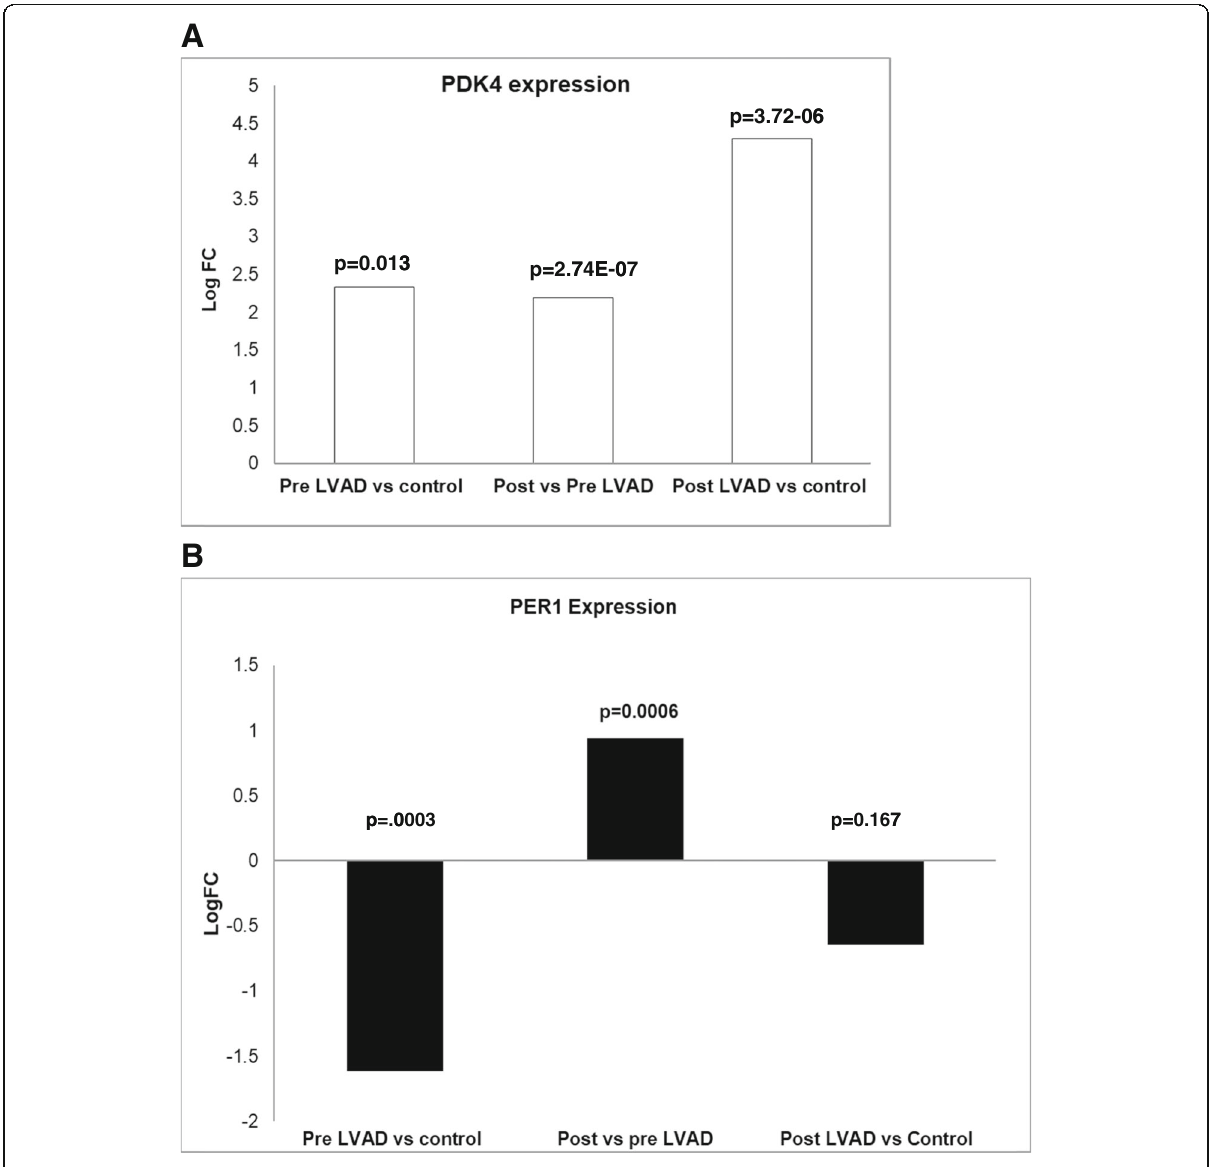
Fig. 1 Differential gene expressions levels with LVAD therapy. a PKD4 expressions compared with pre LVAD and control, pre and post LVAD and post LVAD and control. b PER1 expression compared with pre LVAD and control, pre and post LVAD and post LVAD and